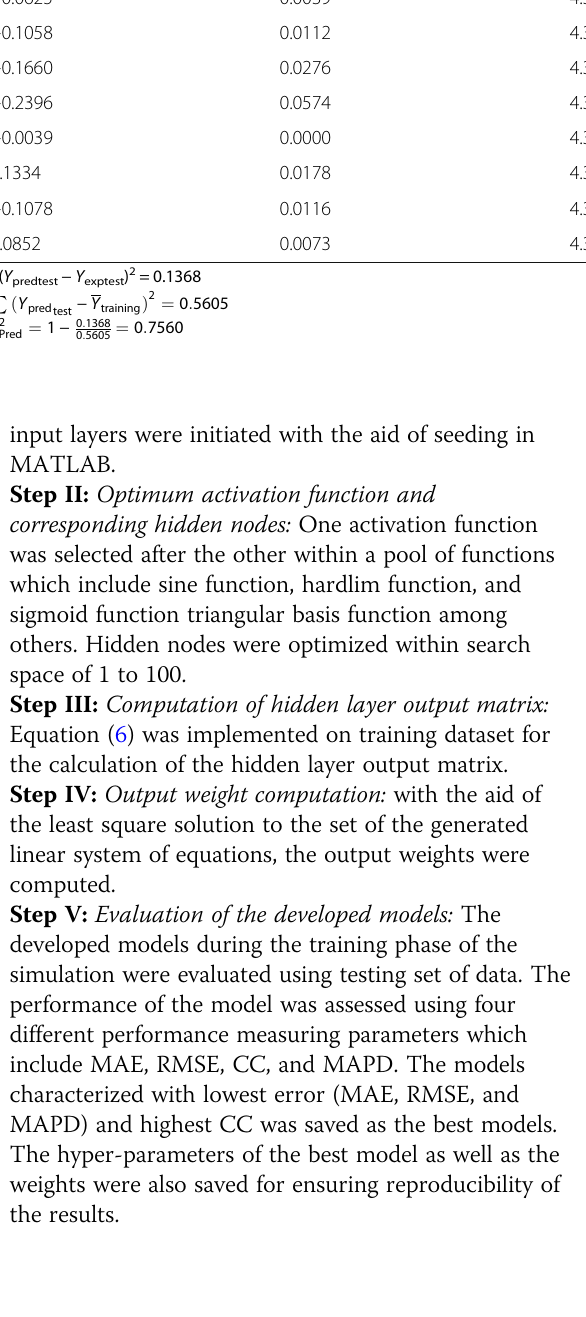
Table 7 Pearson ’ s correlation matrix, VIF and ME of the descriptors used in the built model